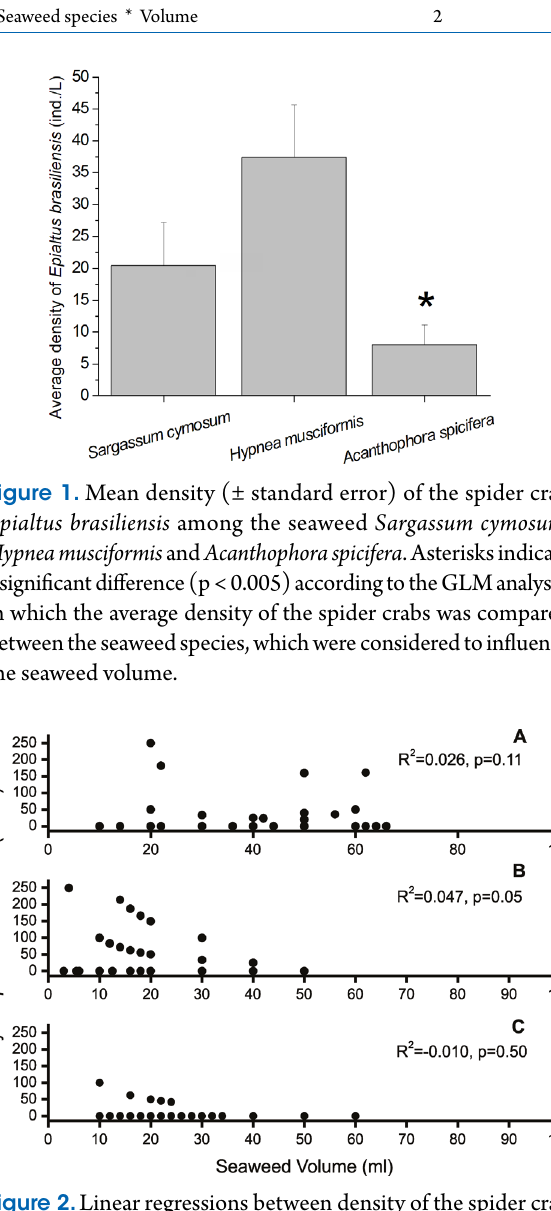
Figure 2. Linear regressions between density of the spider crab Epialtus brasiliensis and the seaweed volumes. A, Sargassum cymosum; B, Hypnea musciformis and C, Acanthophora spicifera .